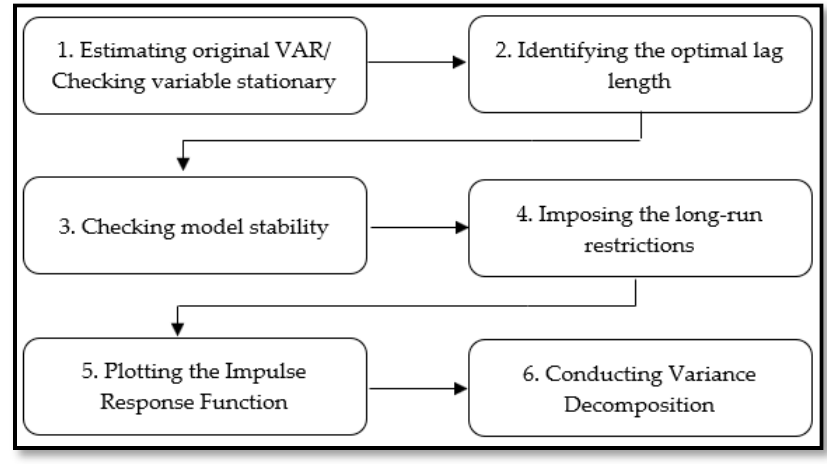
Figure 1. Conceptual framework.